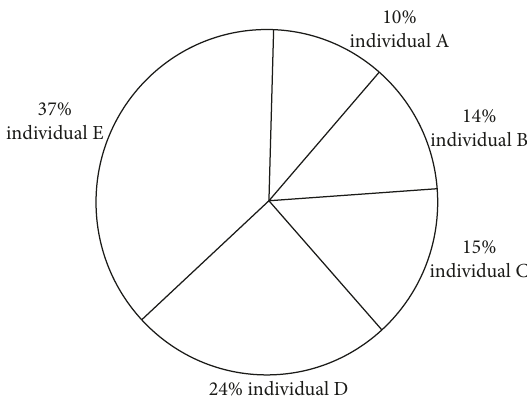
Figure 3: Roulette wheel